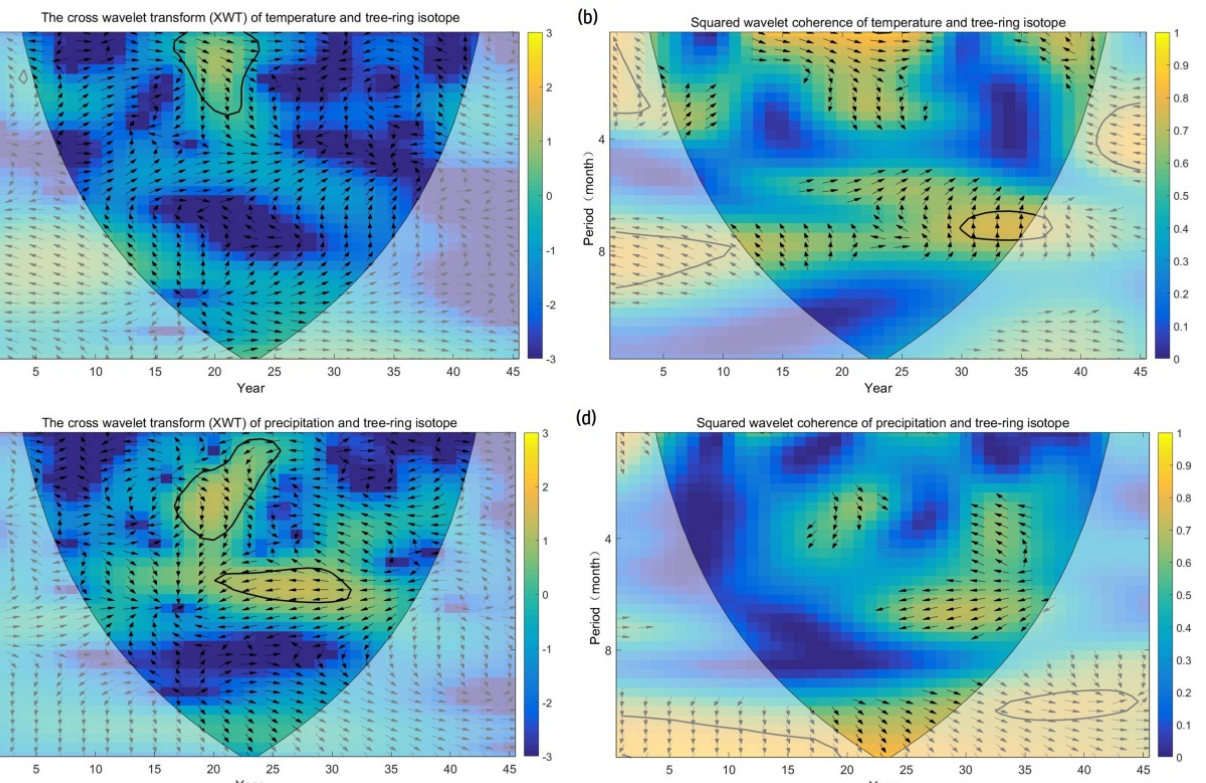
moving average (ARIMA) models pre-whitened time series data of flows.